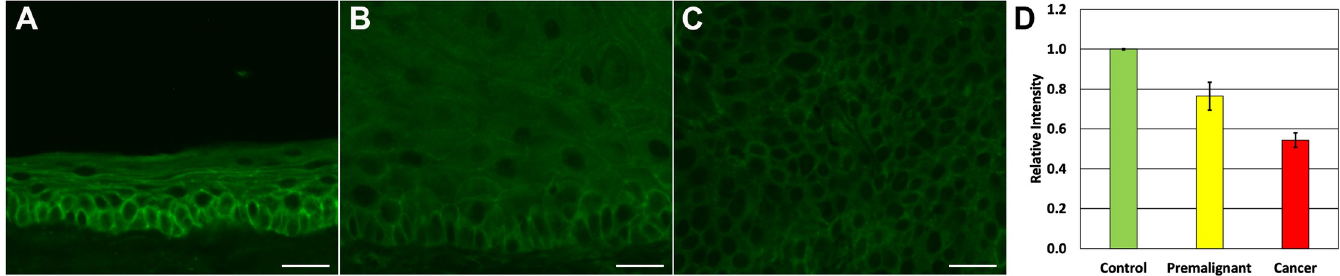
Fig 1. Decreased membranous expression of p120ctn in DBPDE-induced premalignant and cancer lesions. Staining for p120ctn was performed on oral mucosal tissue harvested from C57Bl/6 mice treated with DBPDE (n = 15) or DMSO (n = 10) as control mice. Representative samples are shown for: (A) Normal oral tissue from control mice, (B) premalignant tissue with decreased p120ctn expression, (C) invasive tumor with decreased p120ctn expression. (D) Quantification of p120ctn mean fluorescent intensity. Scale Bar = 20uM.